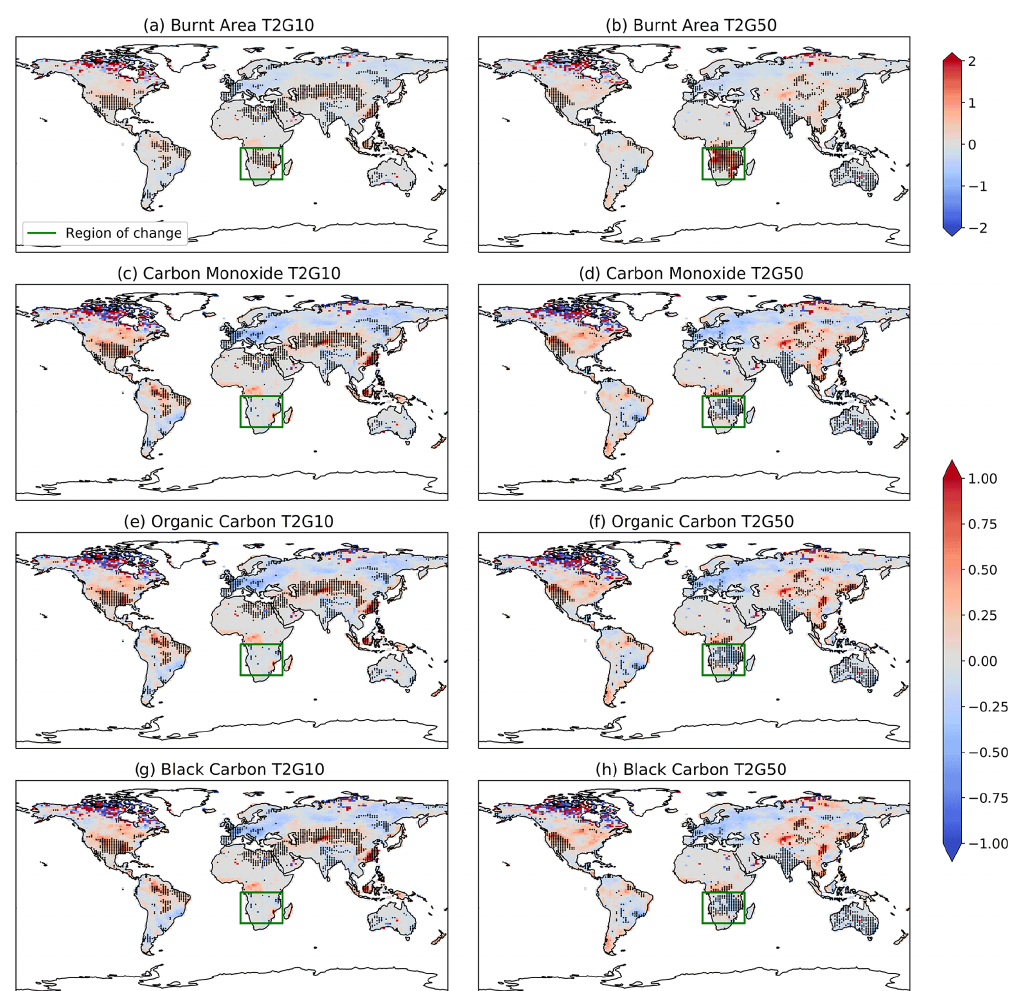
Figure 8. Total annual average fractional of change (period between 1980–1985) of burnt area (Mha), carbon monoxide, organic carbon and for black carbon for the UKESM1+INFERNO and the different sensitivity experiments, T2G10 and T2G50. Stippling is shown for points where the difference between a given experiment and UKESM1+INFERNO is statistically significant with a 95% confidence level. The green rectangle indicates the area where the prescribed vegetation was